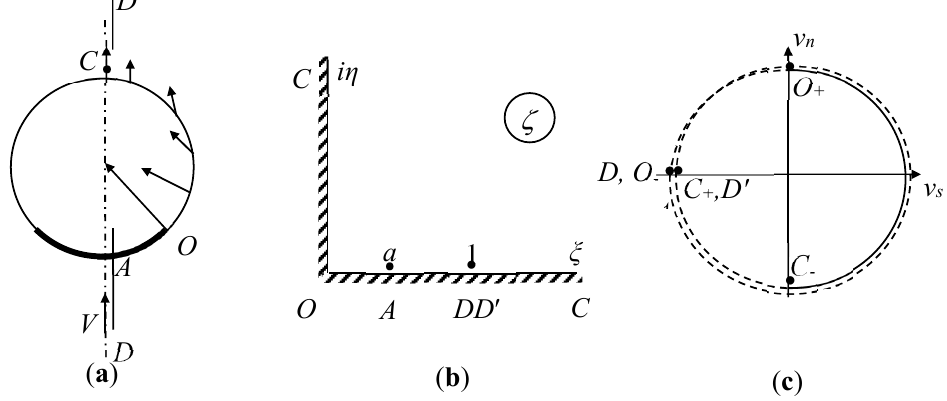
Figure 3. ( a ) Sketch of an impact between a circular arc and a cylindrical free surface; ( b ) ζ plane; ( c ) variation of the function ω = tan − 1 ( v n / v s ) along the whole boundary of the liquid region. Continuous and step changes in ω are shown by solid and dashed lines, respectively.